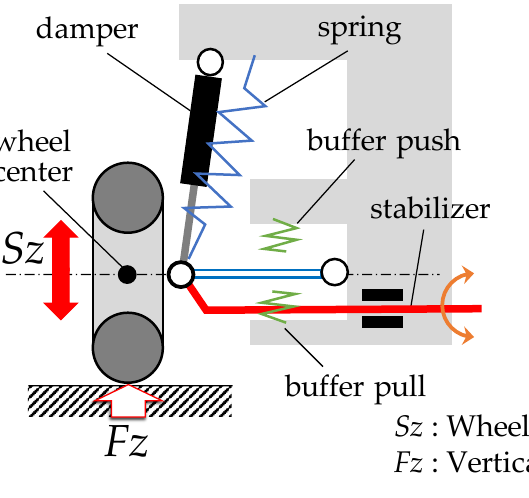
Figure 28. Energy consumption mechanism.